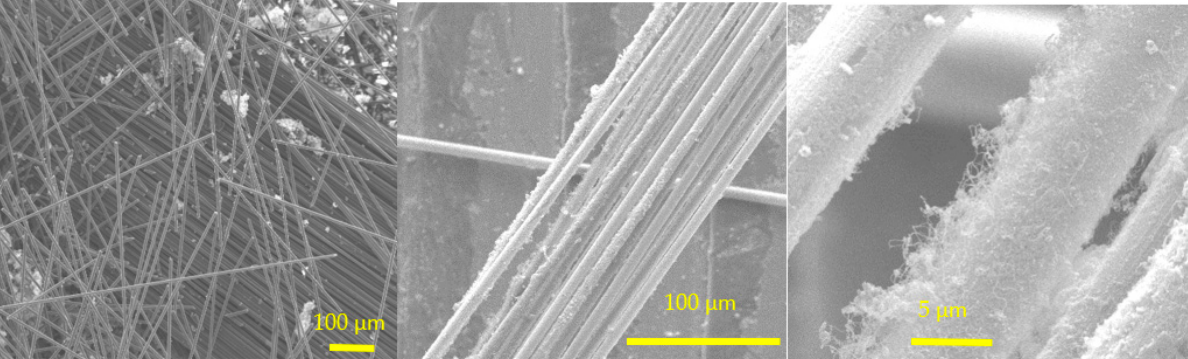
Figure 5. CNTs on chopped CFs (floating catalyst approach: catalyst: ferrocene; carbon source: ethanol).